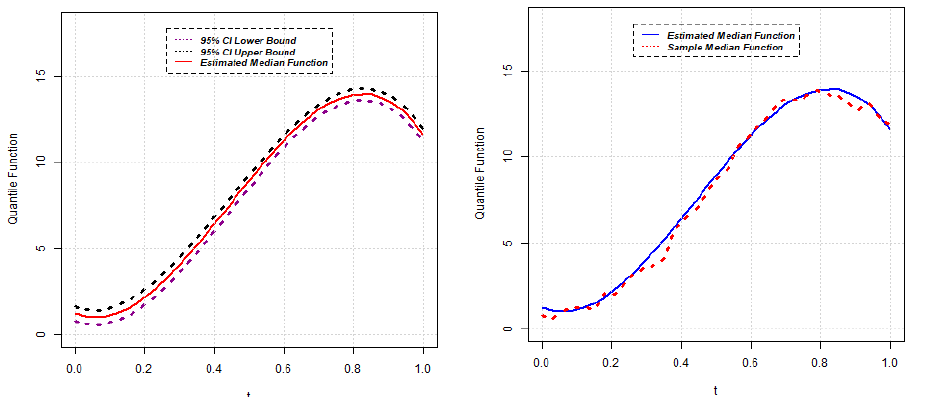
Figure 10. Estimated median function and C.I. ( left ); Estimated median and sample median ( right ) for Model